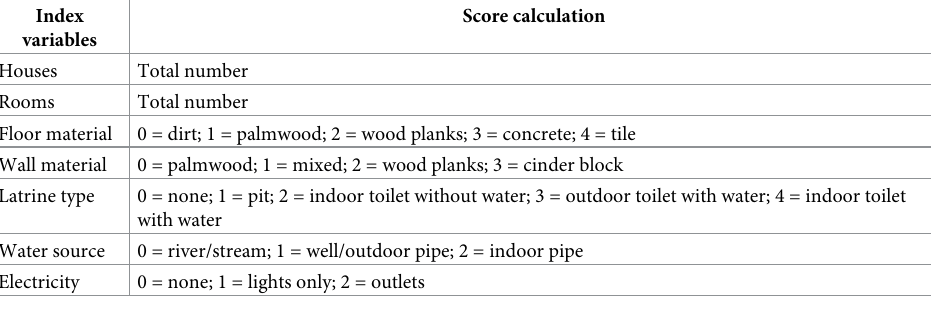
Table 1. Shuar Household Style Of Life (H-SOL)